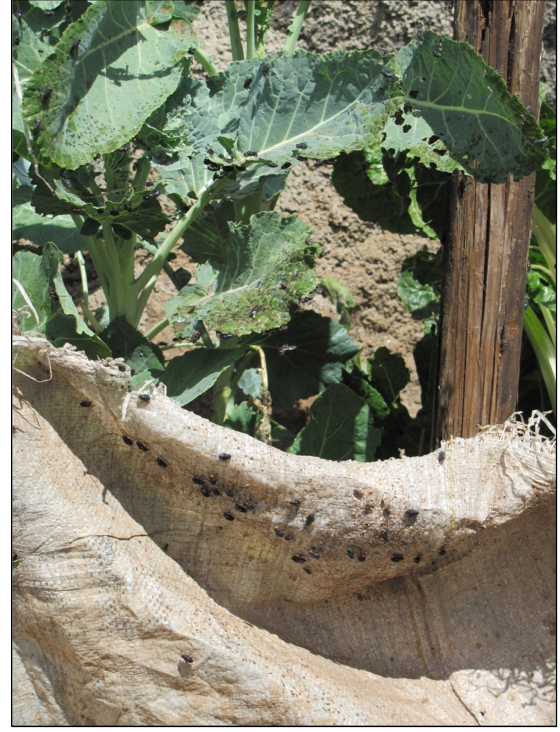
Figure 4. Because Sacks Were Frequently Placed Near Open Sewage Ditches or Latrines, Flies Were a Common Problem Farmers had to carefully wash their crops to remove the fly excrement before eating the